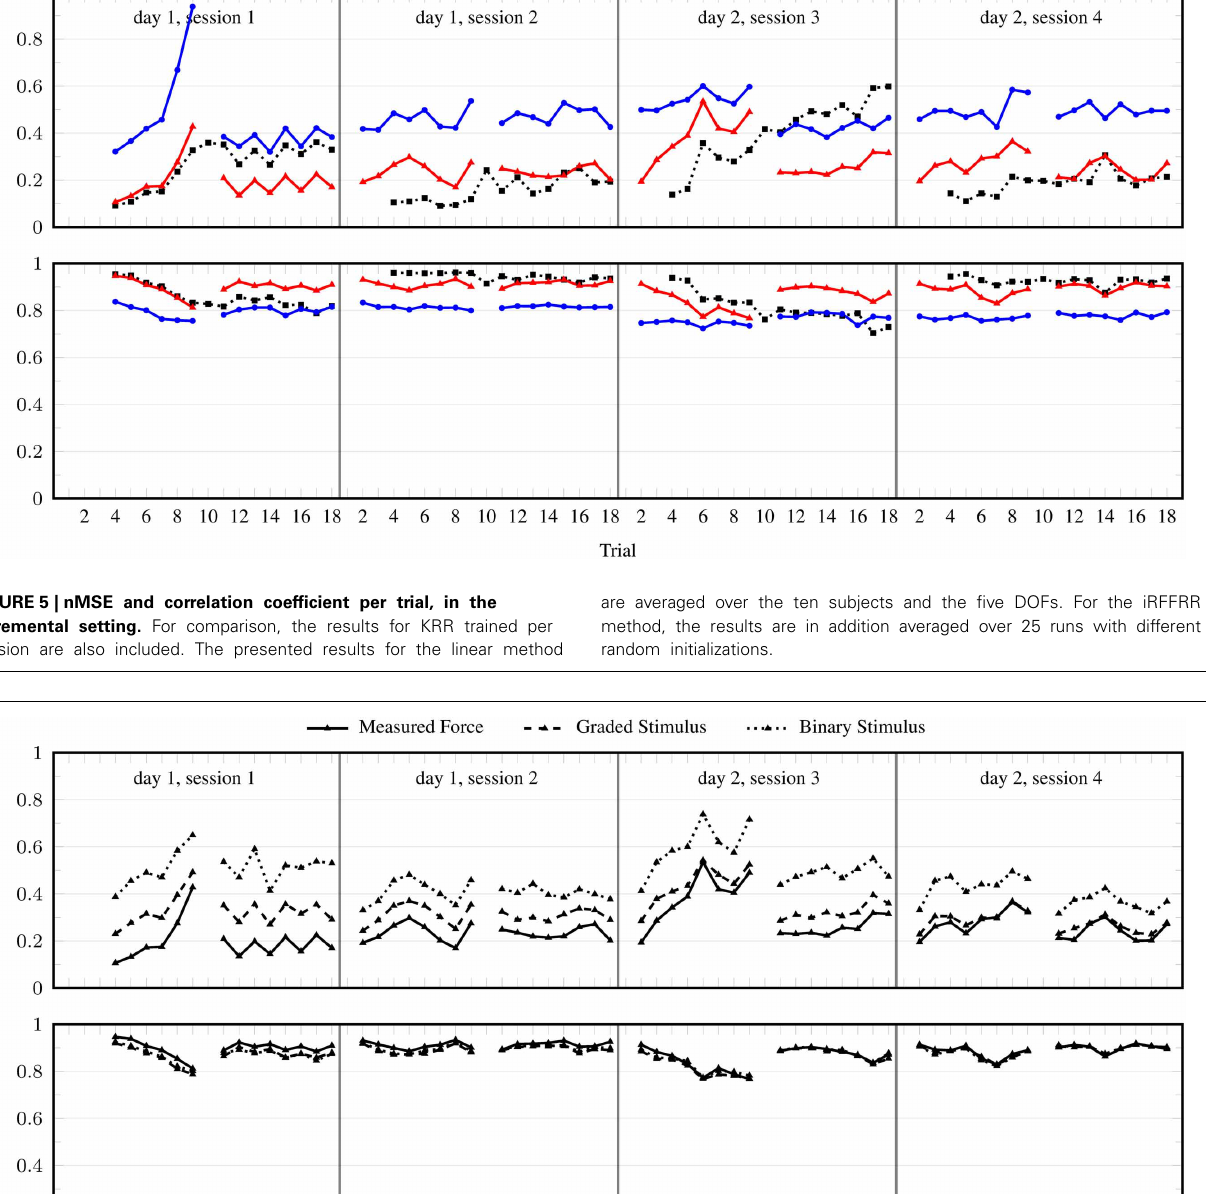
FIGURE 6 | nMSE and correlation coefficient per trial obtained by iRFFRR 1000 , in the incremental setting (training on measured forces) and in the realisticsetting1(trainingongradedstimulus)and2(trainingonbinarystimulus). Theresultsareaveragedover25runswithdifferentrandominitializations.